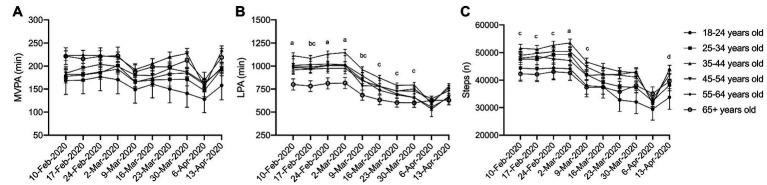
Physical activity during physical distancing by age. (A) MVPA; (B) LPA; (C) Steps; (a) 35–44 year olds are significantly different from 55 to 64 and 65+ year olds; (b) 65+ year olds are significantly different from 45 to 54 year olds; (c) 65+ year olds are significantly different from 35 to 44 year olds; (d) 55–64 year olds are significantly different from 25 to 34 year olds. For clarity, only selected significant differences are indicated on the figure.